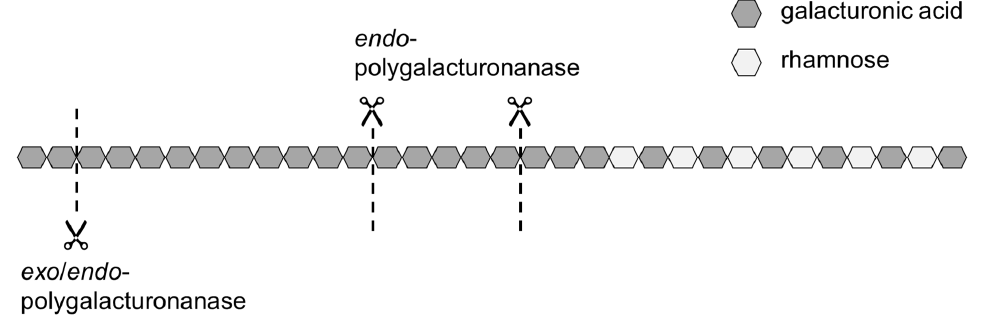
Figure 1. Schematic illustration of the enzymatic modification with the enzymes exo- and endo- pol- ygalacturonanase used in this